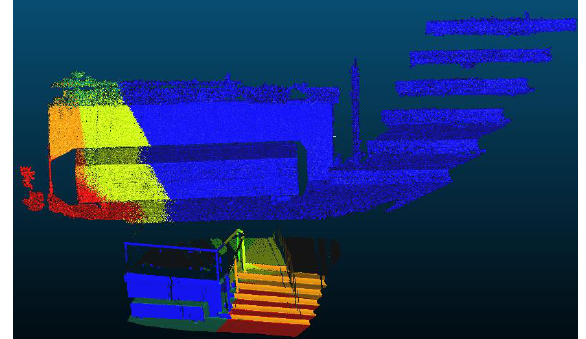
Figure 5: Surface Normal, TLS (below) and Photogrammetry (above) ANN Segmentation The data segmented into six with k-means according to intensity and curvature by MATLAB (Figure 6).